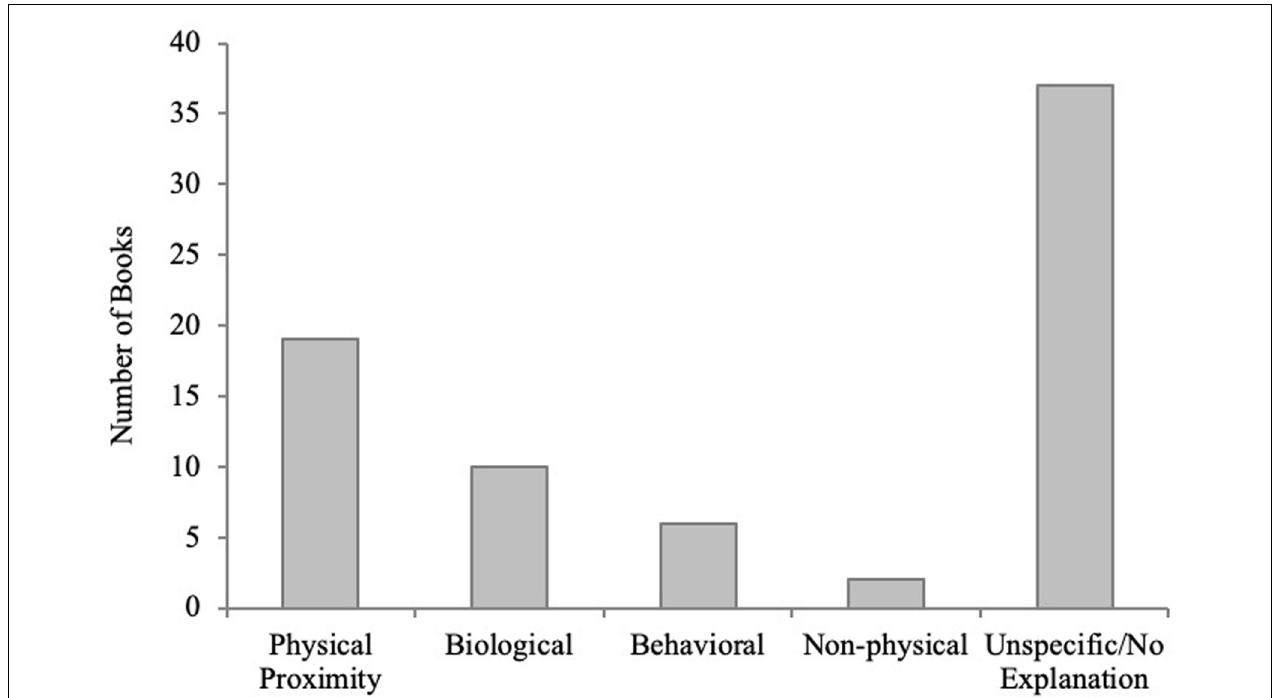
FIGURE 1 | Number of storybooks that provided physical proximity, biological, behavioral, non-physical justice, and no/unspecified explanations for illness transmission in Study 1.